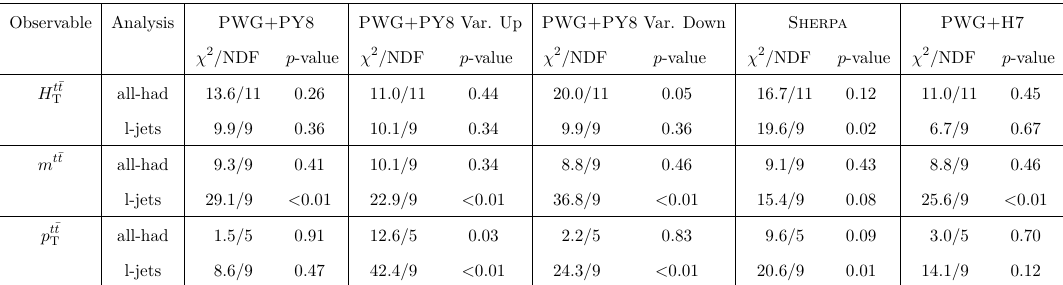
Table 18 . Selection of measured parton-level absolute single-differential cross-sections for all- hadronic and single lepton analyses for predictions from several MC generators. For each prediction, a χ 2 and a p -value are calculated using the covariance matrix of the measured spectrum. The number of degrees of freedom (NDF) is equal to the number of bins in the distribution.